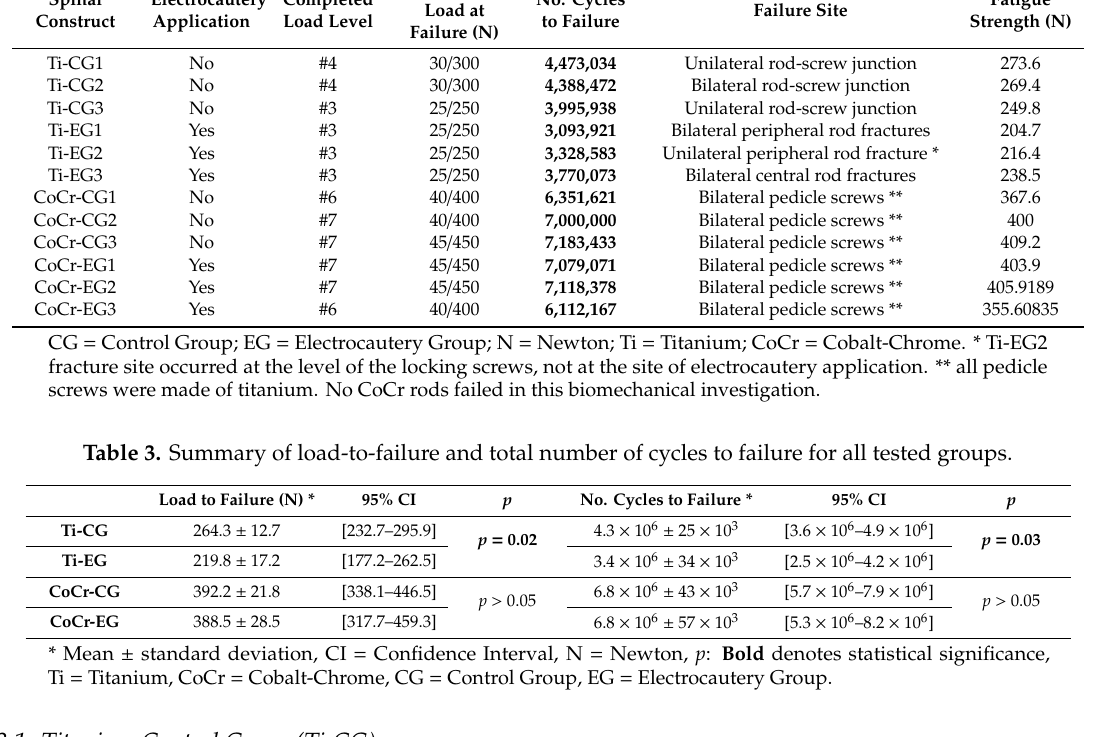
Figure 5. Boxplot representing the mean and 25% and 75% interquartile range of the total number of cycles to failure among the four tested groups.